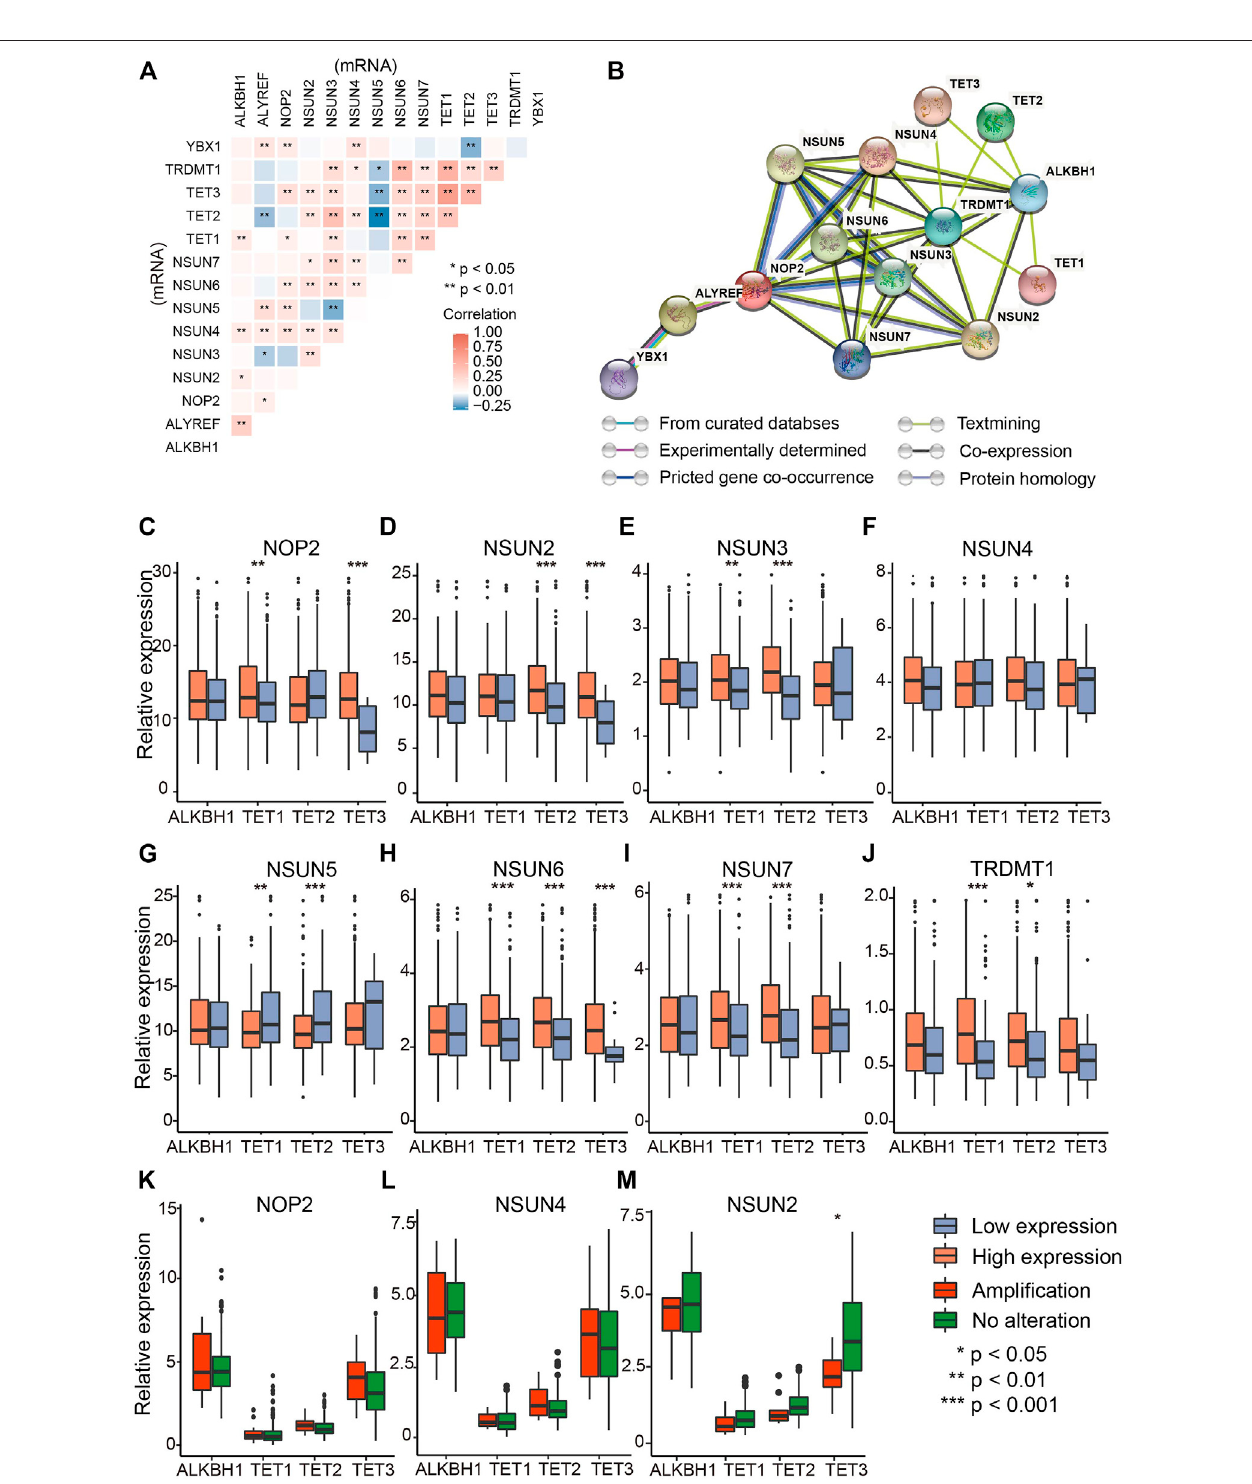
FIGURE 2 | The interaction and correlation analysis between RNA m 5 C regulators in ovarian cancer. (A) Correlation of mRNA levels among m 5 C regulators. (B) Protein – protein interaction plot among the 14 m 5 C regulators. (C – J) Correlations between “ writers ” (NUSN1, NSUN2, NSUN3, NSUN4, NSUN5, NSUN6, NSUN7, TRDMT1) and “ erasers ” (TET1, TET2, TET3, ALHBK1) at mRNA level (RPKM). (K – M) Differential mRNA levels of “ erasers ” between ampli fi ed type and wild type of “ writers ” with the highest CNV frequencies (NOP2, NSUN4, and NSUN2).